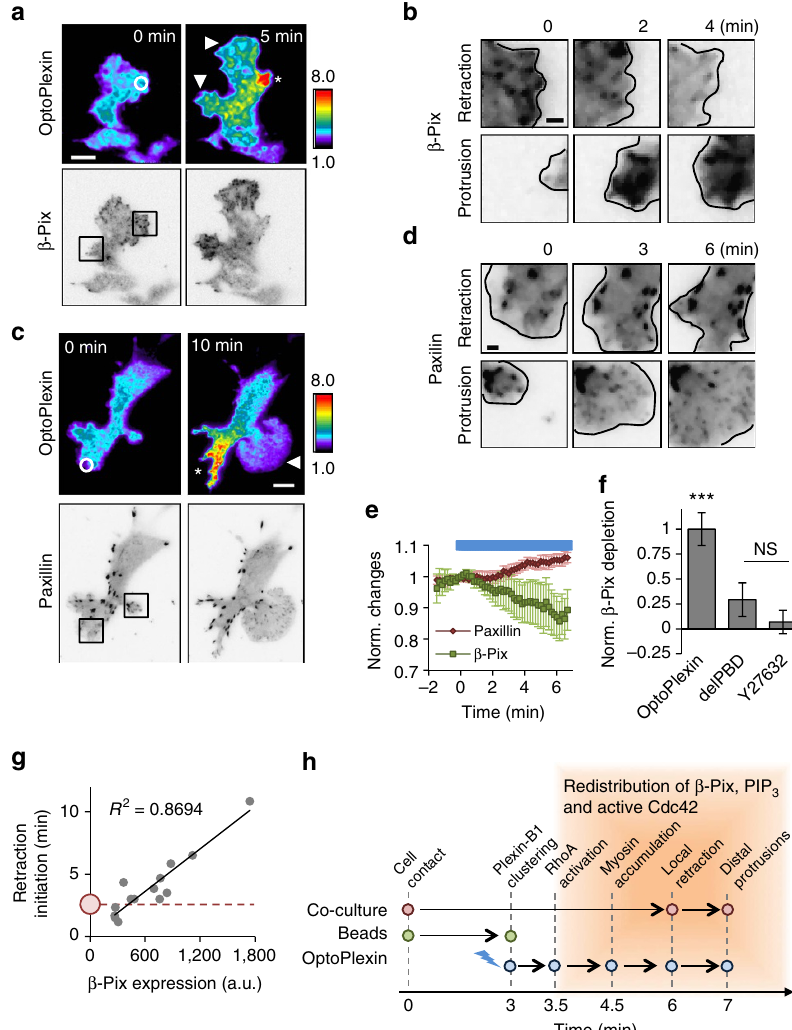
Figure 9 | OptoPlexin mobilizes and redistributes b -Pix to distal regions. TIRF images showing intensity changes of mCherry-optoPlexin and mVenus- b -Pix ( a ) or mVenus-optoPlexin and mCherry-Paxillin ( c ) in MC3T3-E1 cells upon local illumination. White circle, region of illumination. Scale bar, 10 m m. Asterisk, induced retraction. Arrowhead, induced protrusion. Inset squares in a and c are magnified to show temporal changes in mVenus- b -Pix ( b ) or mCherry-Paxillin ( d ) at induced retractions ( b , d , top panels) or protrusions ( b , d , bottom panels). Scale bar, 2 m m. ( e ) Quantification of fluorescence intensities of mCherry-Paxillin ( n ¼ 10 cells) and mVenus- b -Pix ( n ¼ 18 cells) in a 50 m m-diameter circle centred at the region of illumination on local optoPlexin activation in MC3T3-E1 cells. Blue line, illumination at 440nm. ( f ) Quantification of mVenus- b -Pix depletion in a 50 m m-diameter circle centred at the region of illumination upon local illumination of MC3T3-E1 cells expressing optoPlexin, delPBD or optoPlexin with addition of 10 m M Y-27632 ( n ¼ 10–18 cells). ( g ) Delay in initiation of retraction upon local activation of mCherry-optoPlexin with respect to exogenous b -Pix expression levels in MC3T3-E1 cells Red circle indicates mean delay in initiation of retraction by local activation of mCherry-optoPlexin in MC3T3-E1 cells without exogenous b -Pix expression as measured in Fig. 3e. R 2 , Pearson’s correlation coefficient. ( h ) Model of Sema4D-Plexin-B1-mediated CIL between osteoclasts and osteoblasts. For e , f , means ± s.e.m. are shown. *** P o 0.001 and * P o 0.05, NS, not significant, Student’s t